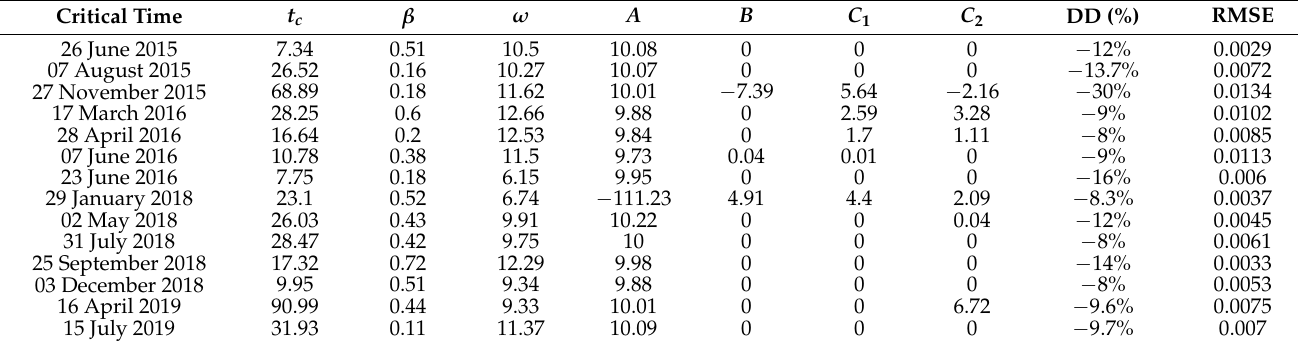
Table 3. Coefficients of the LPPL framework providing a drawdown of >7% in